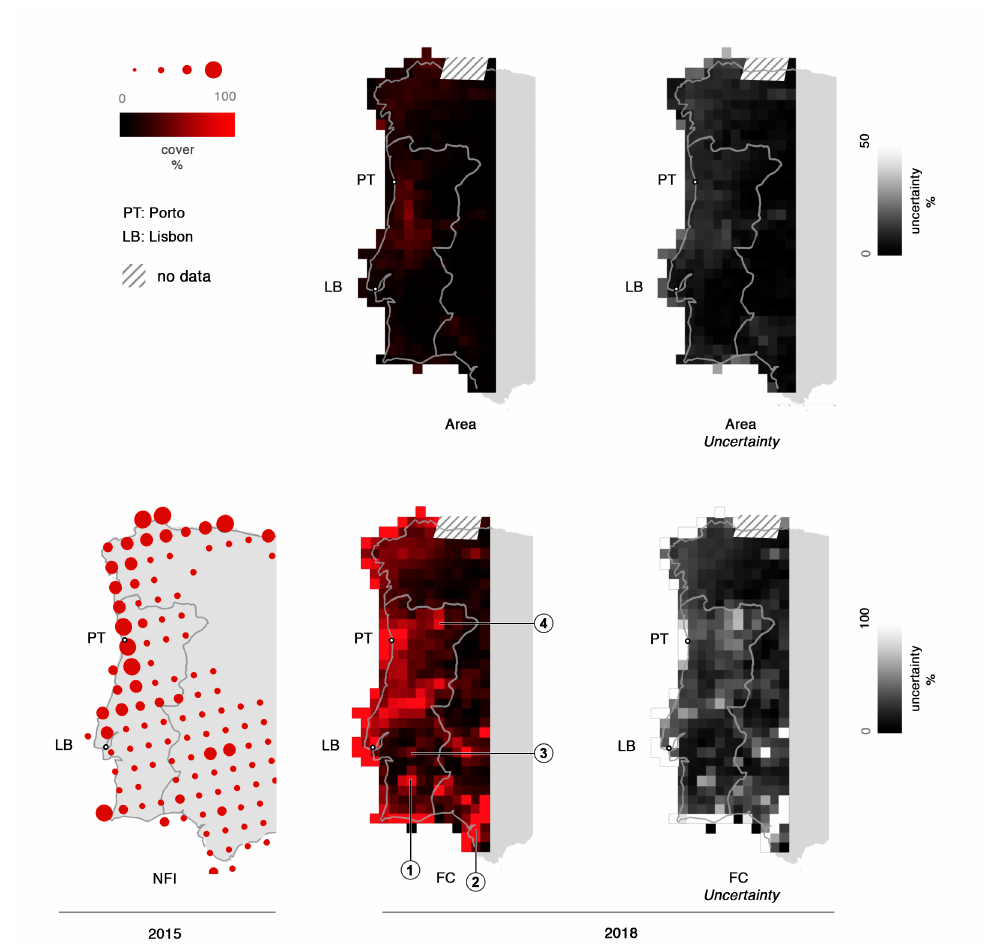
Figure 9. Distribution of areas covered with Eucalyptus in the western Iberian peninsula for the year 2018. The top map shows the percentage of the total area that is covered with Eucalyptus . The bottom map visualizes the percentage that is covered with Eucalyptus with respect to the maximum forest cover (FC) in the years between 2010 and 2018. Uncertainty of the estimates is shown in a separate map. For comparison a map based on data published by Cerasoli et al. [33] which relies on National Forest Inventory (NFI) data for the year 2015 is